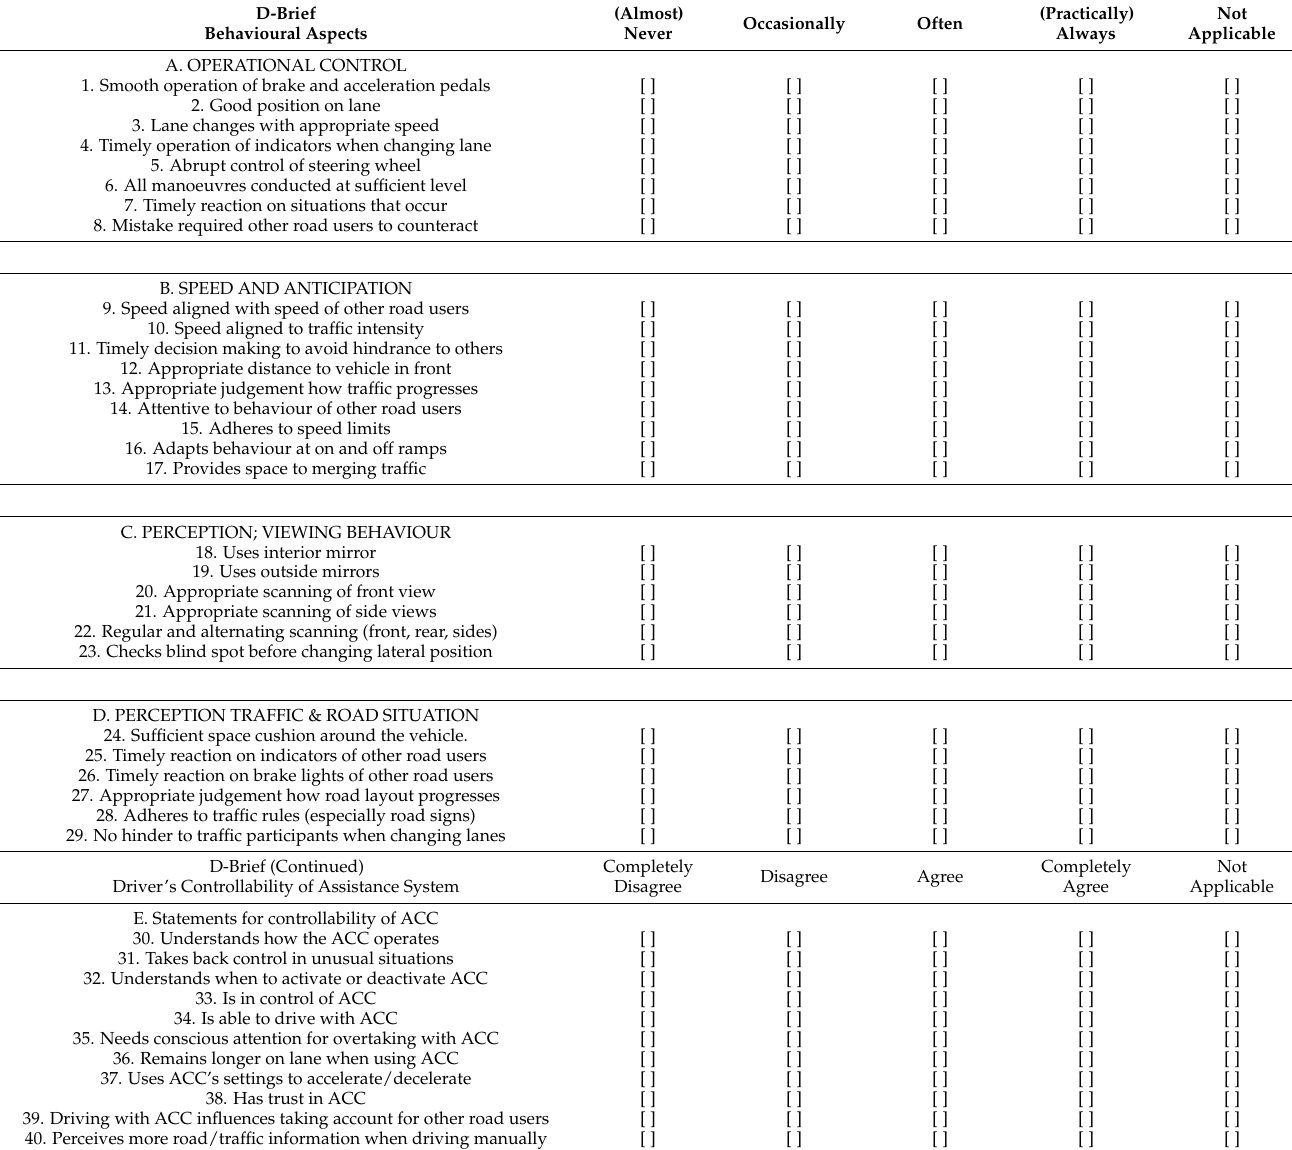
Table A1. Driver Behaviour Rating Index and Evaluation Form